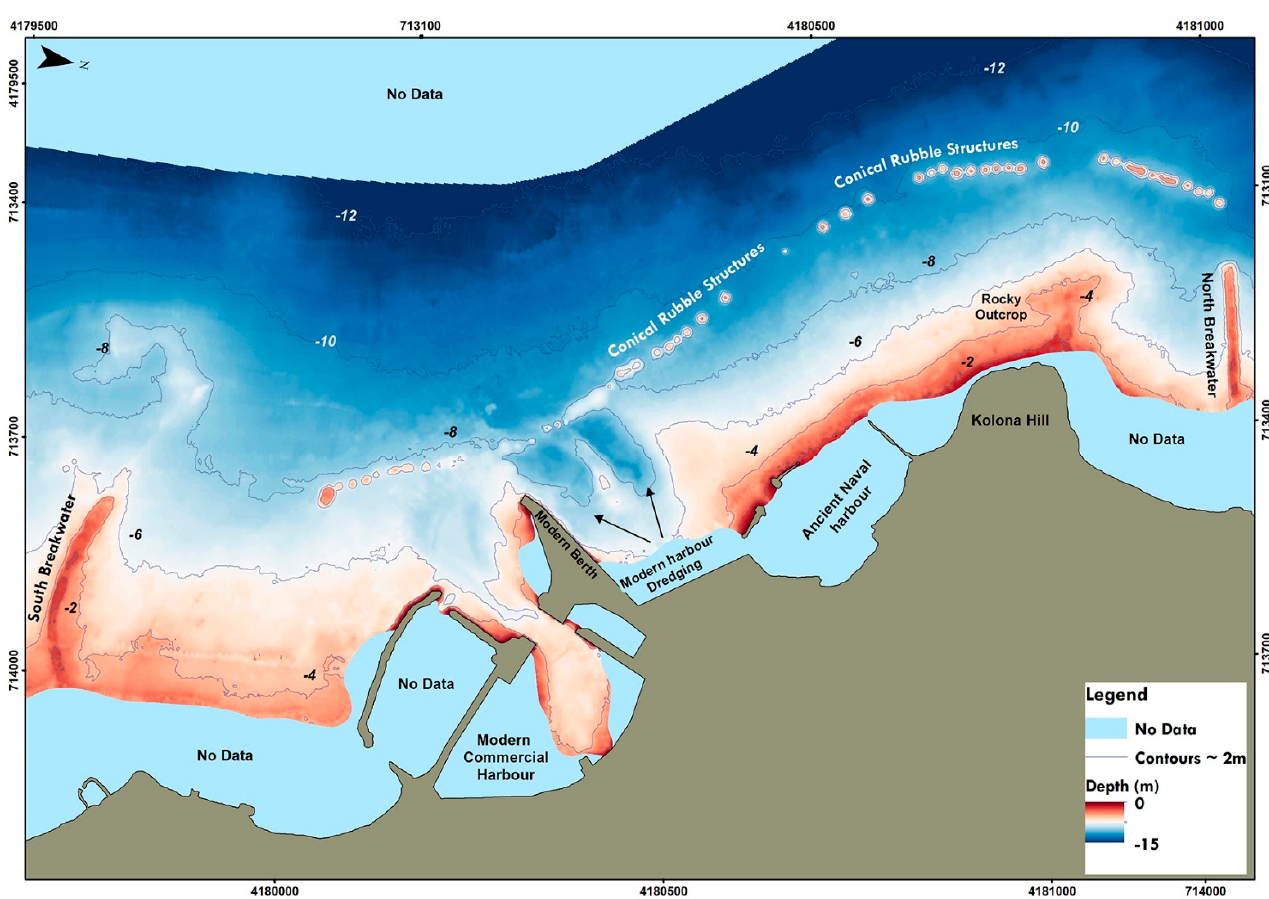
Figure 2. Bathymetric map focused on the submerged archaeological site, bounded by the south and north breakwaters.